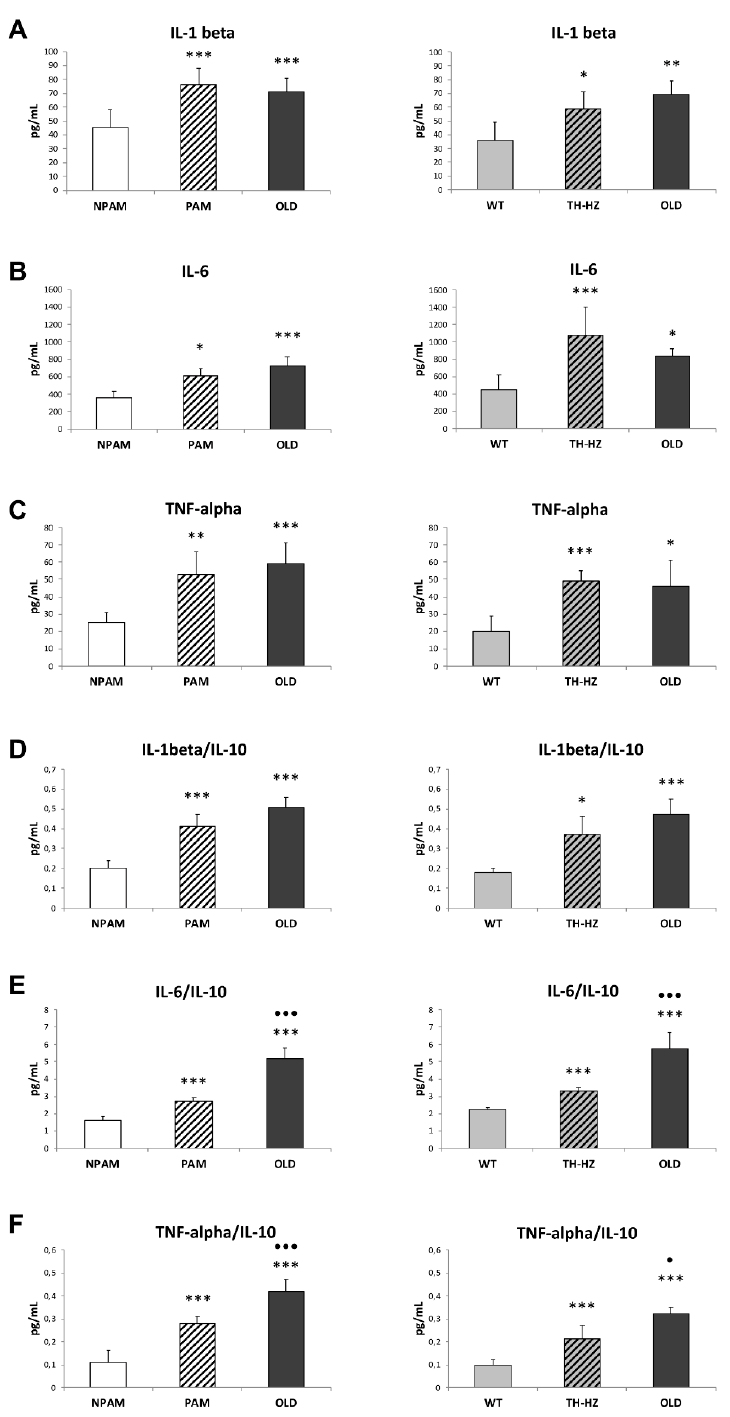
Figure 4. Pro-inflammatory cytokines (pg/mL) released by peritoneal leukocytes incubated in basal conditions, as well as pro-inflammatory/anti-inflammatory ratios. IL-1 β ( A ), IL-6 ( B ), TNF- α ( C ), as well as IL-1 β /IL-10 ( D ), IL-6/IL-10 ( E ), and TNF- α /IL-10 ( F ) ratios in adult PAM, NPAM, TH-HZ,